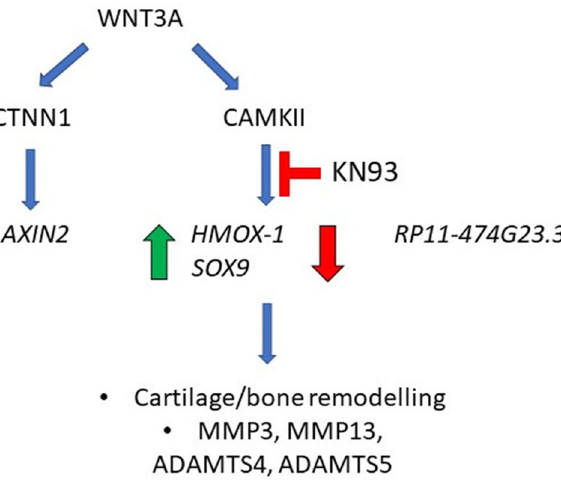
Figure 7. Diagram summarising the transcriptional targets modulated by WNT3A in a CaMKII dependent manner and the effect of the pharmacological blockade of CaMKII on the remodelling of joint tissues in